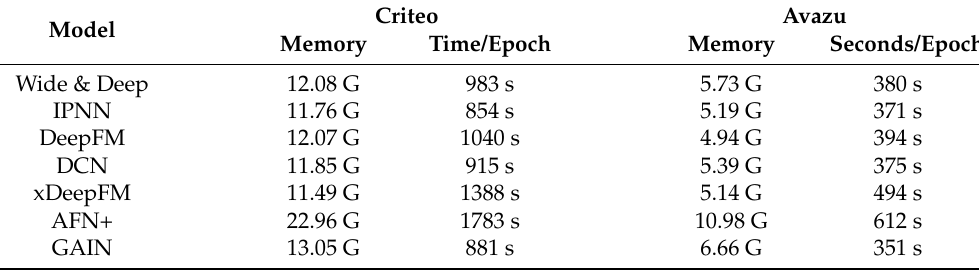
Table 2. Efficiency comparison. The “Memory” columns record GPU’s memory occupation of different models, while the “Time/Epoch” columns record average time consumption per